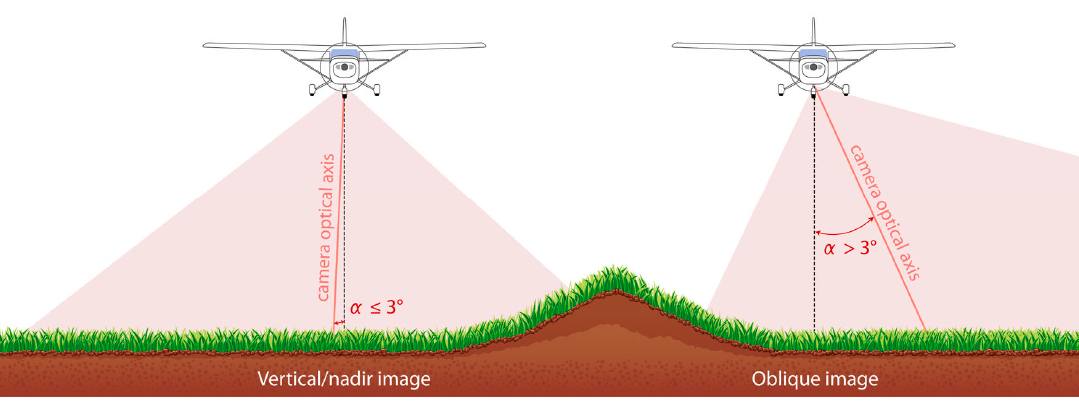
Figure 4. Vertical versus oblique aerial imaging.